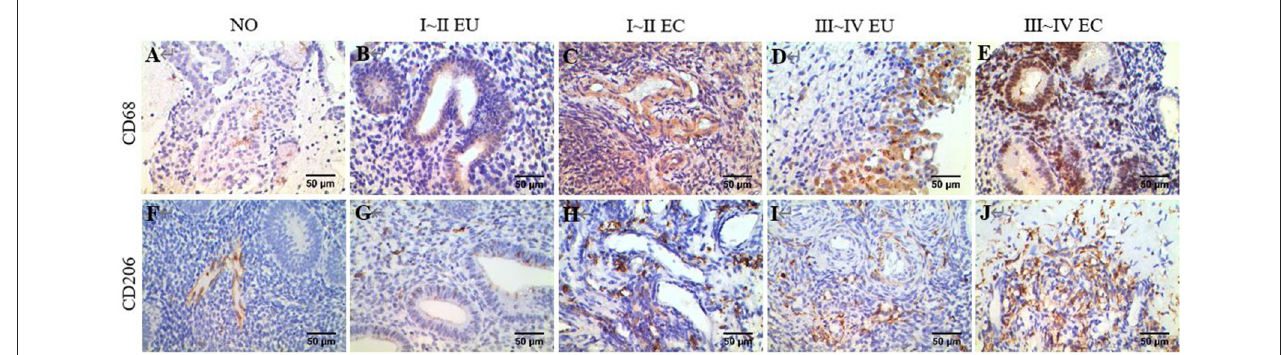
FIGURE 7 | IHC of CD68 and CD206. Brown yellow staining indicates positive expression, and blue staining indicates nuclear staining. (A) Total macrophage CD68 staining in human NO tissue, × 400. (B) Total macrophage CD68 staining in human EU tissue of EMS stage I ∼ II, × 400. (C) Total macrophage CD68 staining in human EC tissue of stage I ∼ II EMS, × 400. (D) Total macrophage CD68 staining in human EU tissue of stage III ∼ IV EMS, × 400. (E) Total macrophage CD68 staining in human EC tissue of stage III ∼ IV EMS, × 400. (F) M2 macrophage CD206 staining in human NO tissue, × 400. (G) M2 macrophage CD206 staining in human EU tissue of stage I ∼ II EMS, × 400. (H) M2 macrophage CD206 staining in human EC tissue of stage I ∼ II EMS, × 400. (I) M2 macrophage CD68 staining in human EU tissue of stage III ∼ IV EMS, × 400. (J) M2 macrophage CD206 staining in human EC tissue of stage III ∼ IV EMS, × 400. All EU and EC tissues were from patients with ovarian endometriomas.